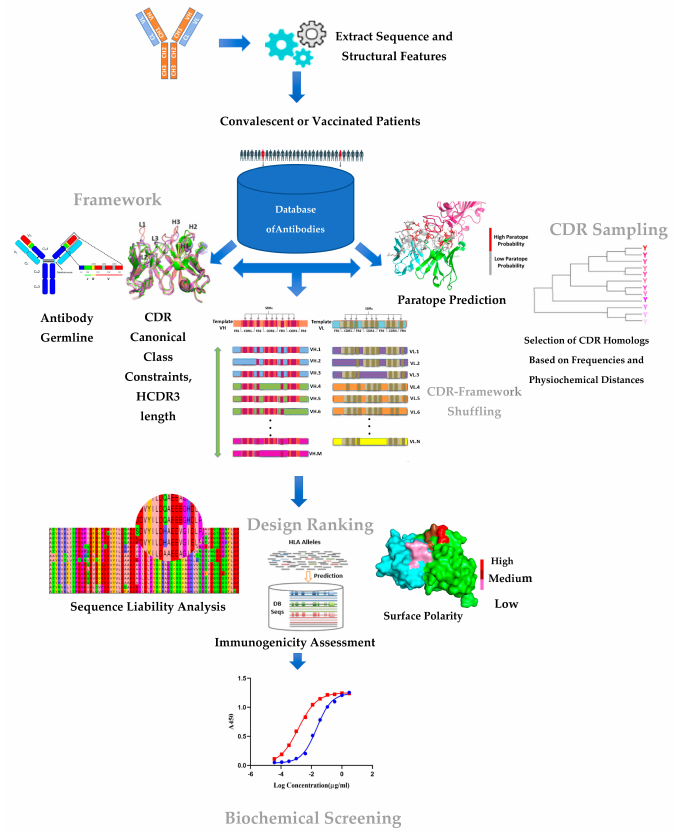
Figure 1. Key components of the CDR–FWR shuffling approach. Starting from a template antibody (selected based on its potency and mechanism of action), the approach involves searching and screening (referred to as sampling) for CDR parts and FWR parts from a large sequence repository of human antibody sequences. The metrics used in the sampling FWR (germline properties, HCDR3 length, etc.) and CDR (paratope prediction and amino acid substitution based on natural frequencies, etc.) are shown. The design space generated by combining the sample CDRs and FWRs are assessed experimentally in a high-throughput manner for quality (expression, yield, thermal stability) and affinity (spot check binding to RBD antigen) to identify the lead